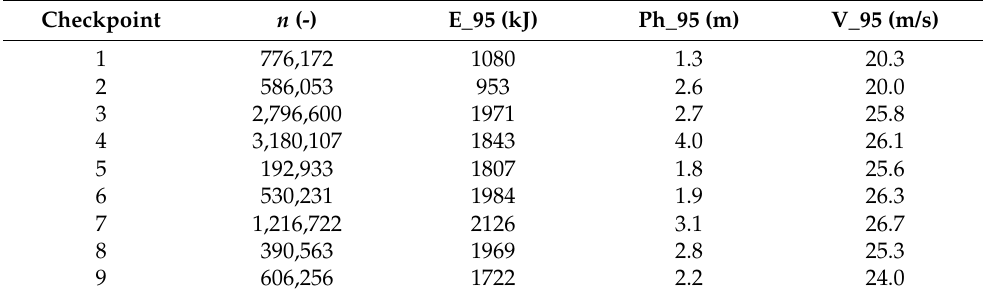
Table 1. Summary of Rockyfor3D simulations outputs for the NFOR scenario. For each checkpoint, the table reports: n , the total number of registered passages of falling rocks; E_95, the 95th percentile of the energy of registered falling rocks; Ph_95, the 95th percentile of passing height values recorded at the checkpoint; V_95, the 95th percentile of the speed of recorded falling rocks.